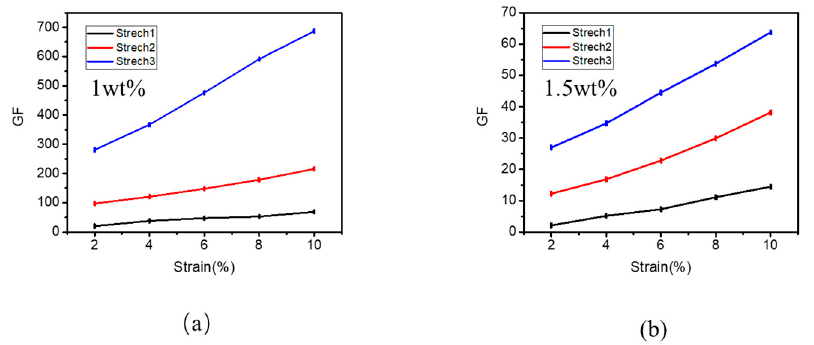
Figure 5. ( a ) GF values of GNP films with a concentration of 1 wt. % under different stretching modes. ( b ) GF values of GNP films with a concentration of 1.5 wt. % under different stretching modes.